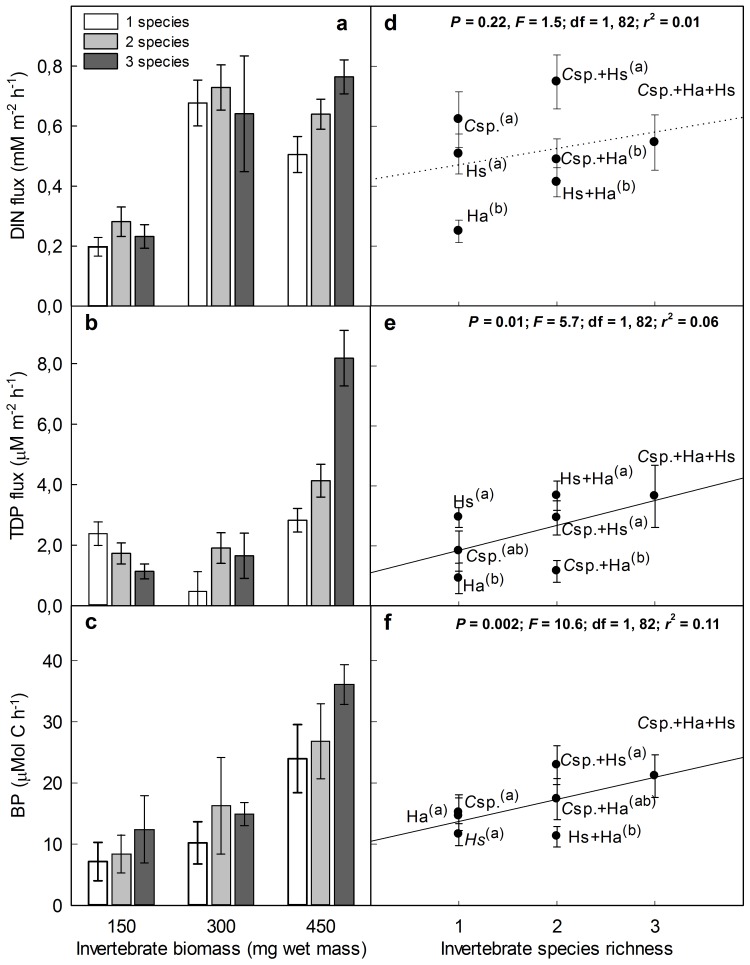
Effects (mean ±1 SE) of invertebrate biomass, species richness and taxonomic composition on (a, d) dissolved inorganic nitrogen (DIN) flux, (b, e) total dissolved phosphorus (TDP) flux and (c, f) bacterioplankton production (BP).Left-hand panels show the interactive effects of invertebrate biomass and species richness on ecosystem processes. Right-hand panels show the overall effects (irrespective of biomass) of species richness and composition (nested factor) on the magnitude of ecosystem processes analyzed. The overall linear effect of species richness was calculated by regressing ecosystem process data from all individual microcosms (n = 84, controls not included) as a function of species richness across all biomass levels. The overall effects of taxonomic composition are shown by nested comparisons among mean values across all biomass levels for each individual species and 2-species mixtures. Treatments marked with different letters within the same species richness level differ significantly from one another (Tukey test, P<0.05). Csp. = Chironomus sp., Hs = Heteromastus similis, Ha = Heleobia australis.